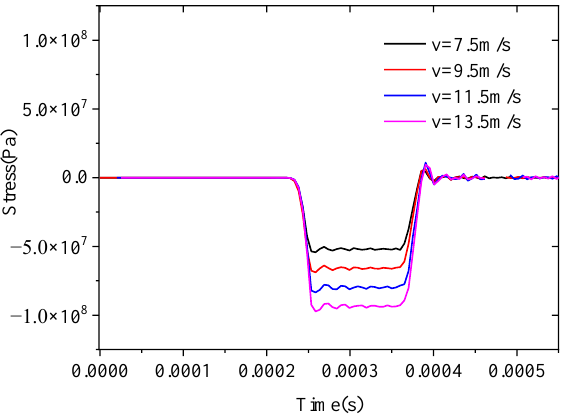
amplitudes conform to the calculation results of σ = ρCv 2⁄ ; the durations are all 158.4 μs,